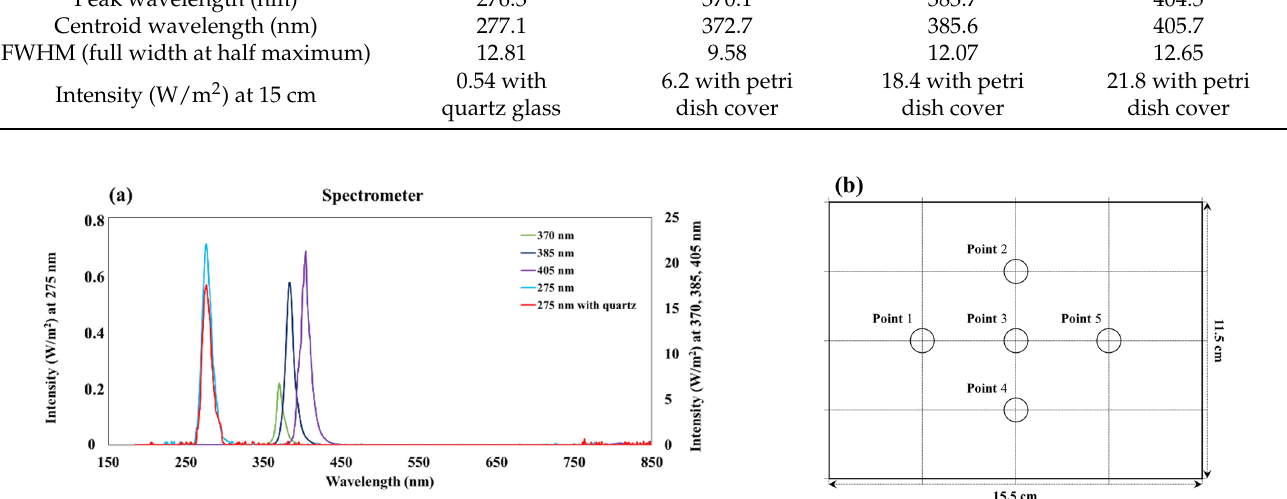
Figure 2. Specifications of the LED modules used in this study. ( a ) Spectra and intensities of the LED modules by wavelength. ( b ) The measurement points of LED module intensity. Table 2. Specifications of the UV-C, near-UV, and visible light LED modules.